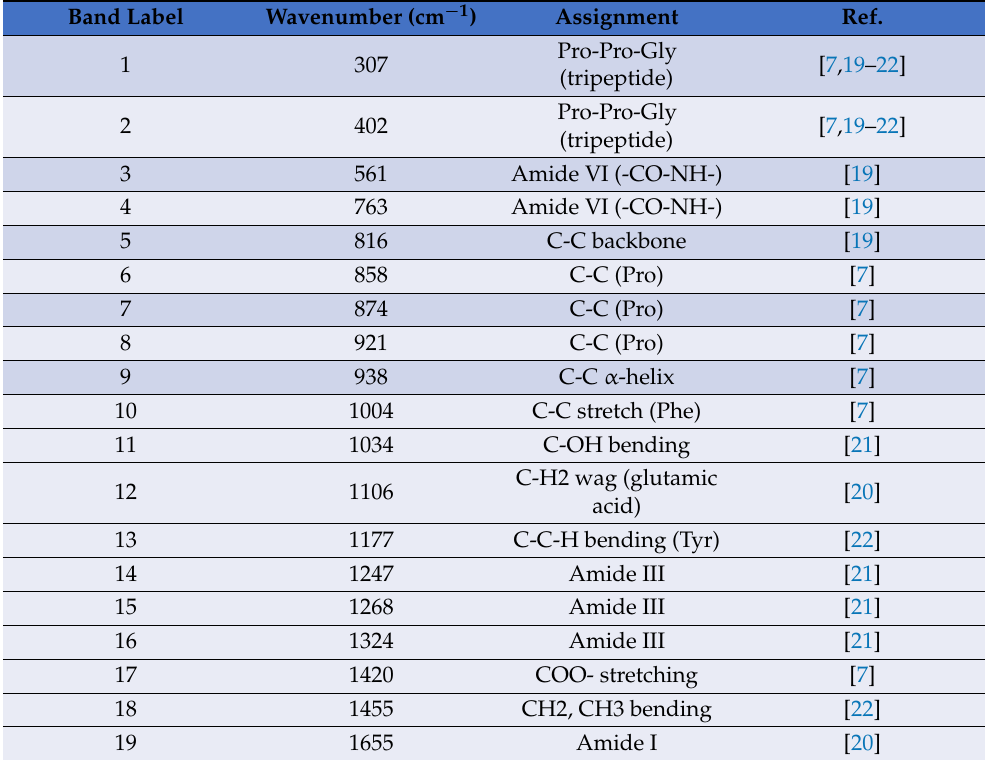
Table 2. Wavenumbers and vibrational assignments of the main Raman bands found in the spectrum of the atelocollagen scaffold (band labels correspond to those shown in Figure 4b. Band